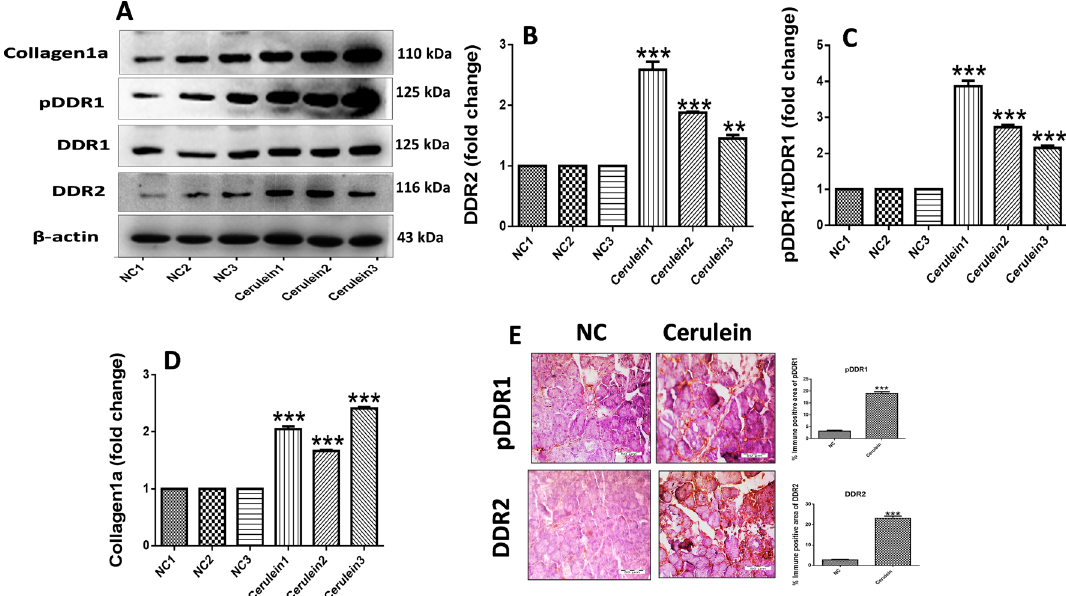
Figure 2. Upregulation of DDR1 and DDR2 in pancreatic fibrosis. ( A–D ) Western blot and corresponding densitometric analysis of protein expression of phosphorylated DDR1, total DDR1, DDR2 and collagen1a